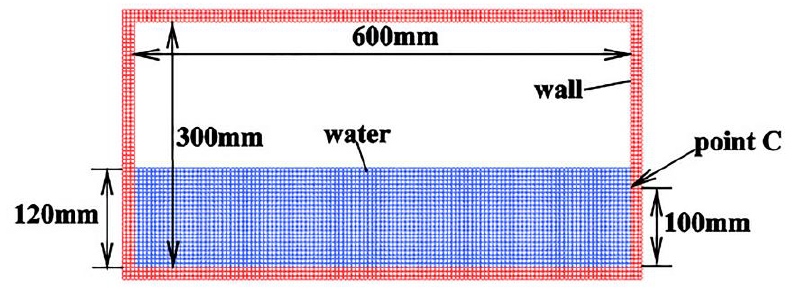
Figure 16. Schematic diagram of the dimensions of the tank.